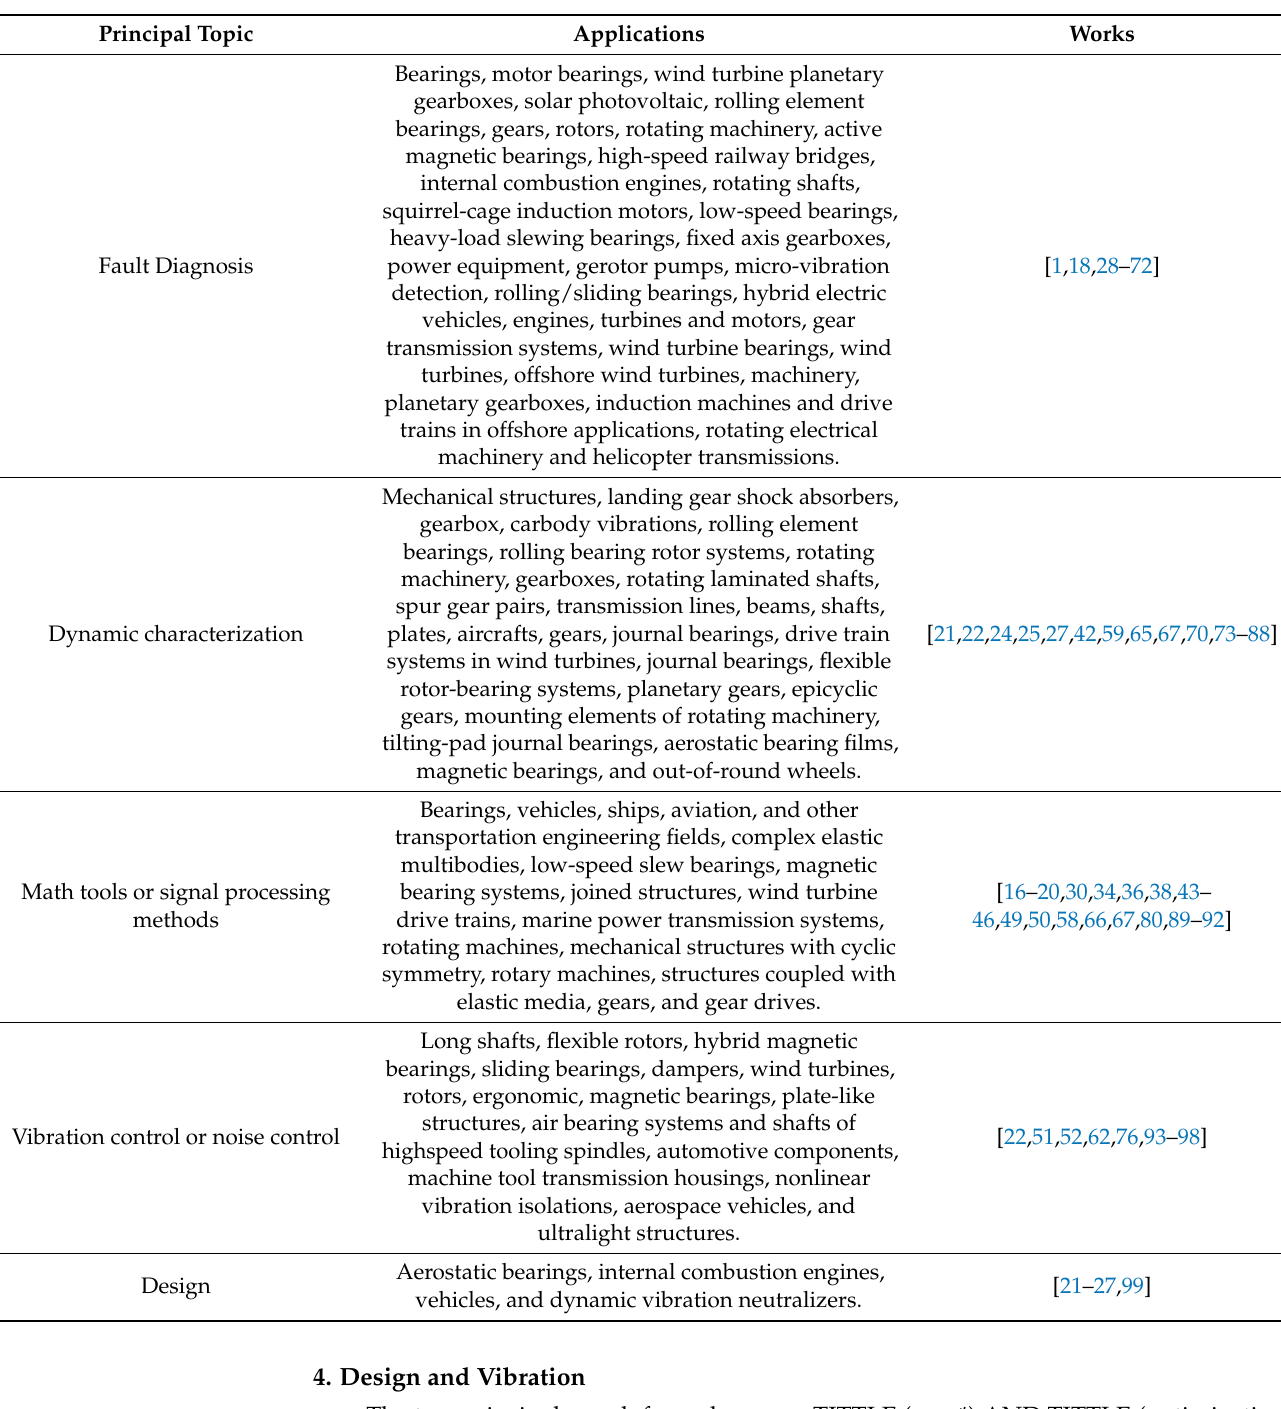
Table 1. Analysis of reviews in the last 20 years of principal elements of power transmission related to